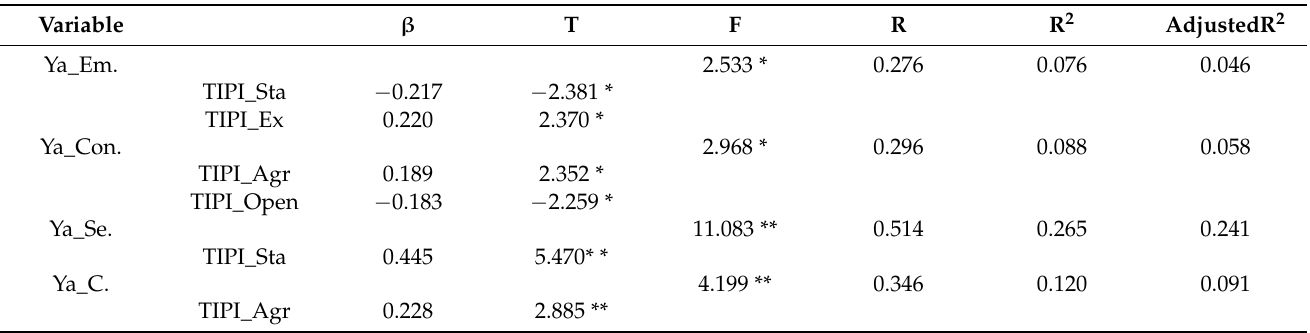
Table 4. Results of multiple regression analyses with personality traits as predictors of moral intelligence in specific